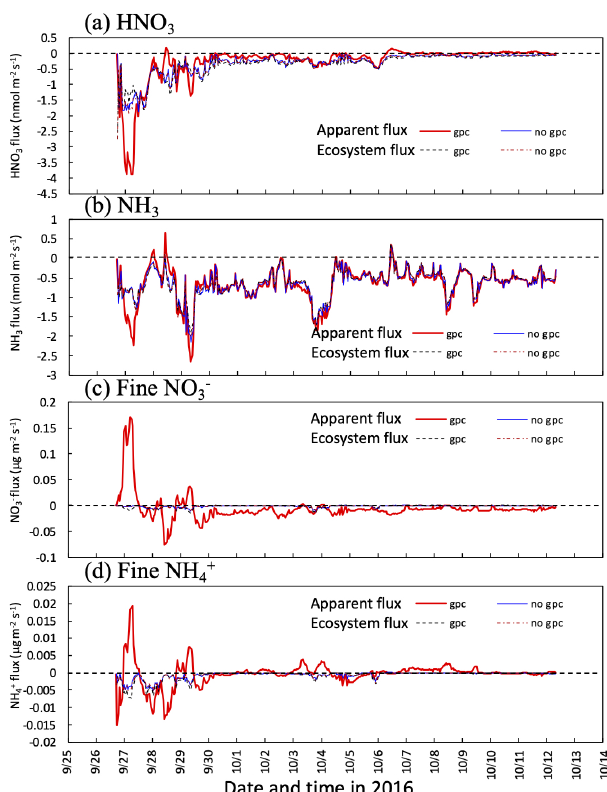
Figure 9. Temporal changes in (a) observed and calculated num- ber concentration of fine and Aitken modes, (b) calculated mass- Figure 8. Temporal changes in calculated apparent mass flux of equivalent ( D g3 ), (c) number-equivalent geometric mean wet di- (a) HNO 3 gas and (b) NO − and NH + fine particles at 30m height in ameter ( D g0 ), and (d) standard deviation ( σ g ) of fine particles at 3 4 two scenarios (gpc and no gpc) between 27 September and 11 Octo- 8m height from 7 November to 7 December 2016. Calculations for ber 2016. Fluxes captured by forest (ecosystem flux) are also plotted four scenarios (gpc, no gpc, gpc dry, and no gpc dry) are plotted in the figure. Please note that the date is given on the x axis in the in the figure. Please note that the date is given on the x axis in the month/day format. month/day